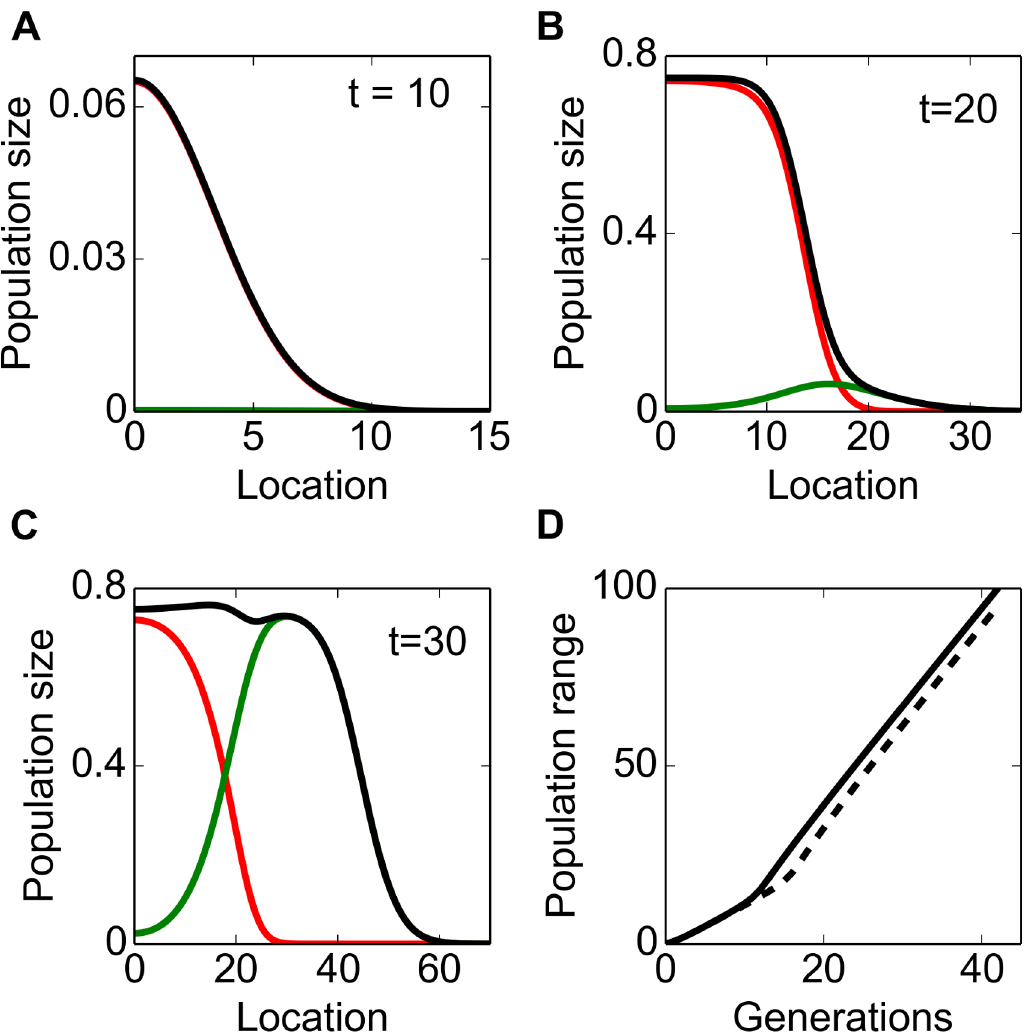
~ 1, d 2 ~ 5 : A–C: Population size at different 1 2